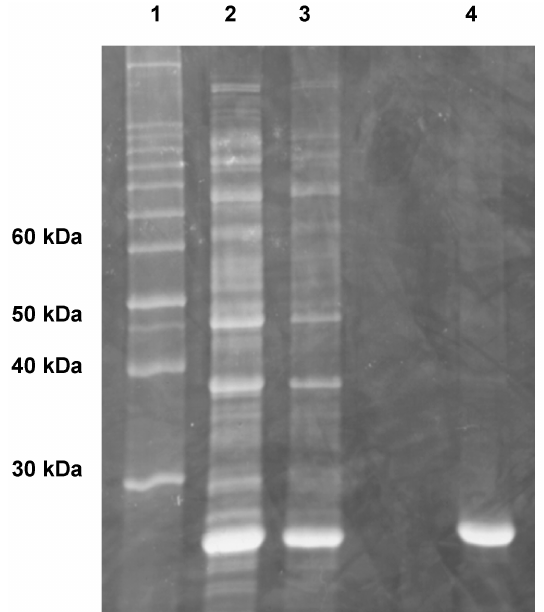
Figure 2. SDS-PAGE analysis of purified M. jannaschii transaldolase. Lane 1:10 kDa proteinmolecularmassmarker. Lane 2:Crude extract. Lane 3: Crude extract after heat treatment. Lane 4: DE52-purified